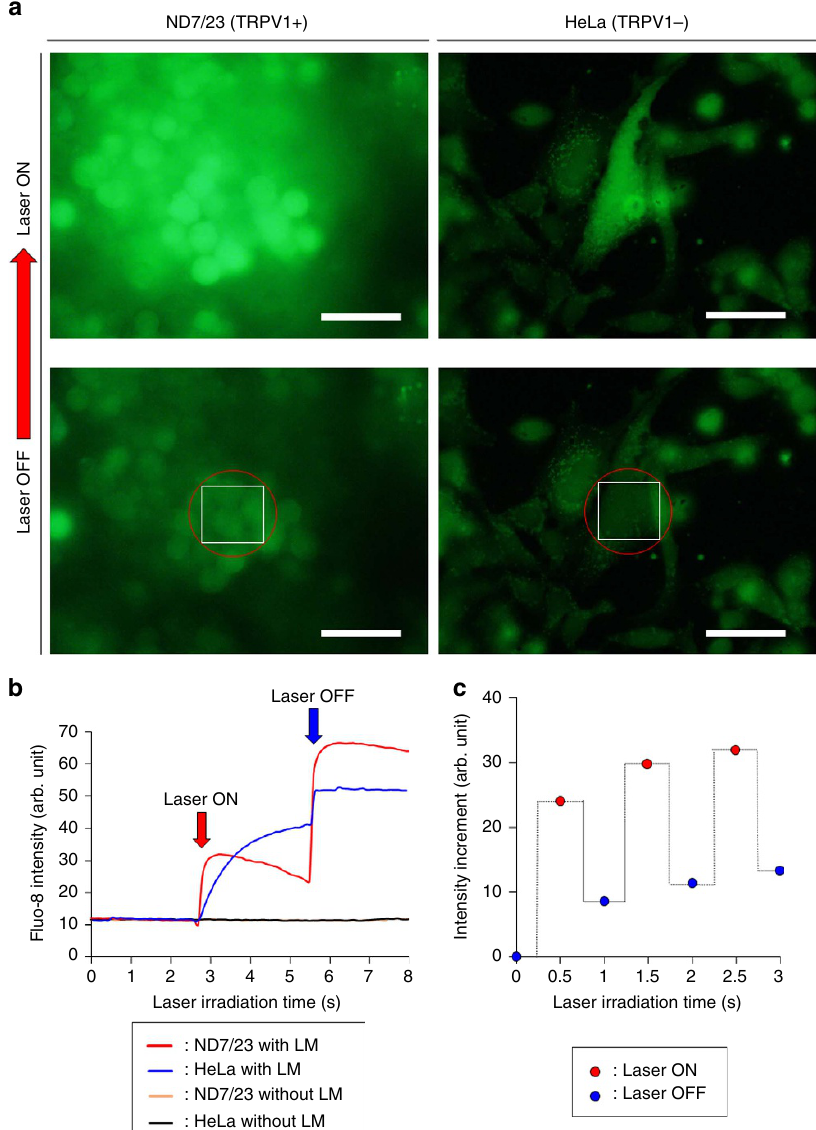
Figure 9 | Cell stimulation by laser-induced LM nanocapsules. ( a ) Calcium influx into ND7/23 and HeLa cells when exposed to a laser source (808nm, 133mW, B 68 m W m m (cid:2) 2 ). The irradiated site is marked with a red circle. White squares show the analysed fluorescent intensity areas. Scale bars, 50 m m. ( b ) Quantification of fluorescence intensity over time. ( c ) Response to multiple laser irradiation